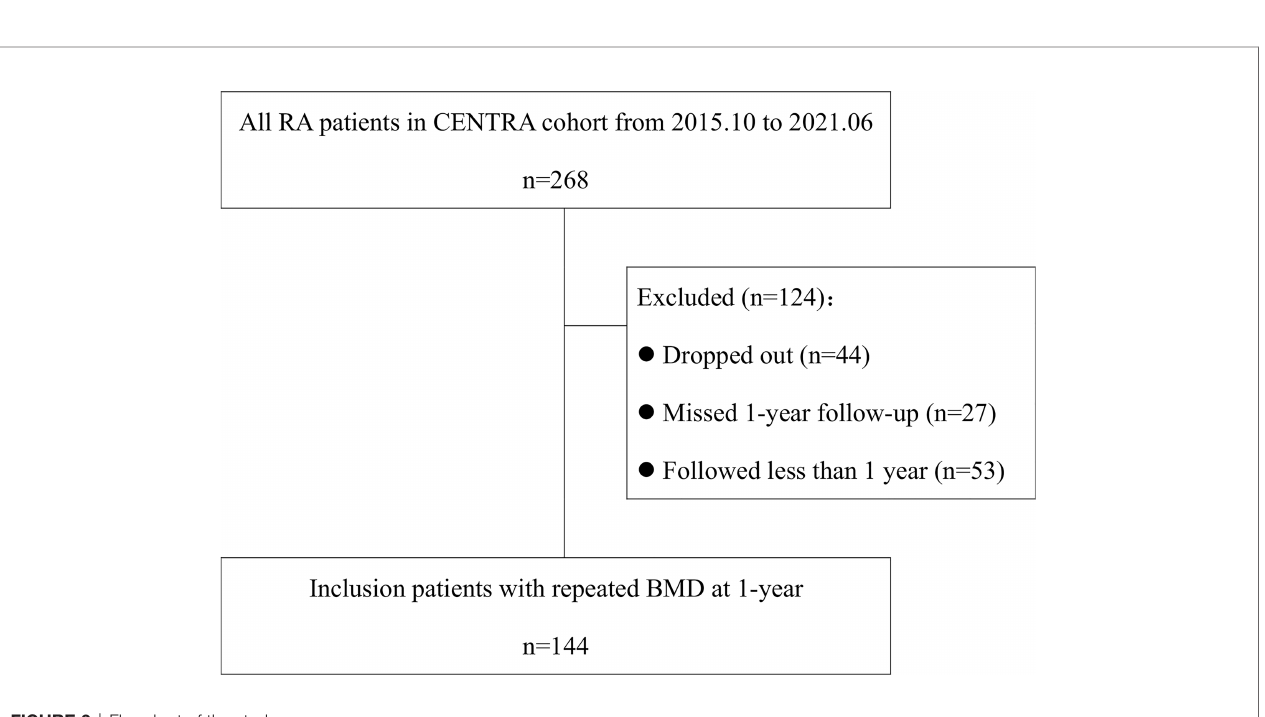
FIGURE 3 | Flowchart of the study.